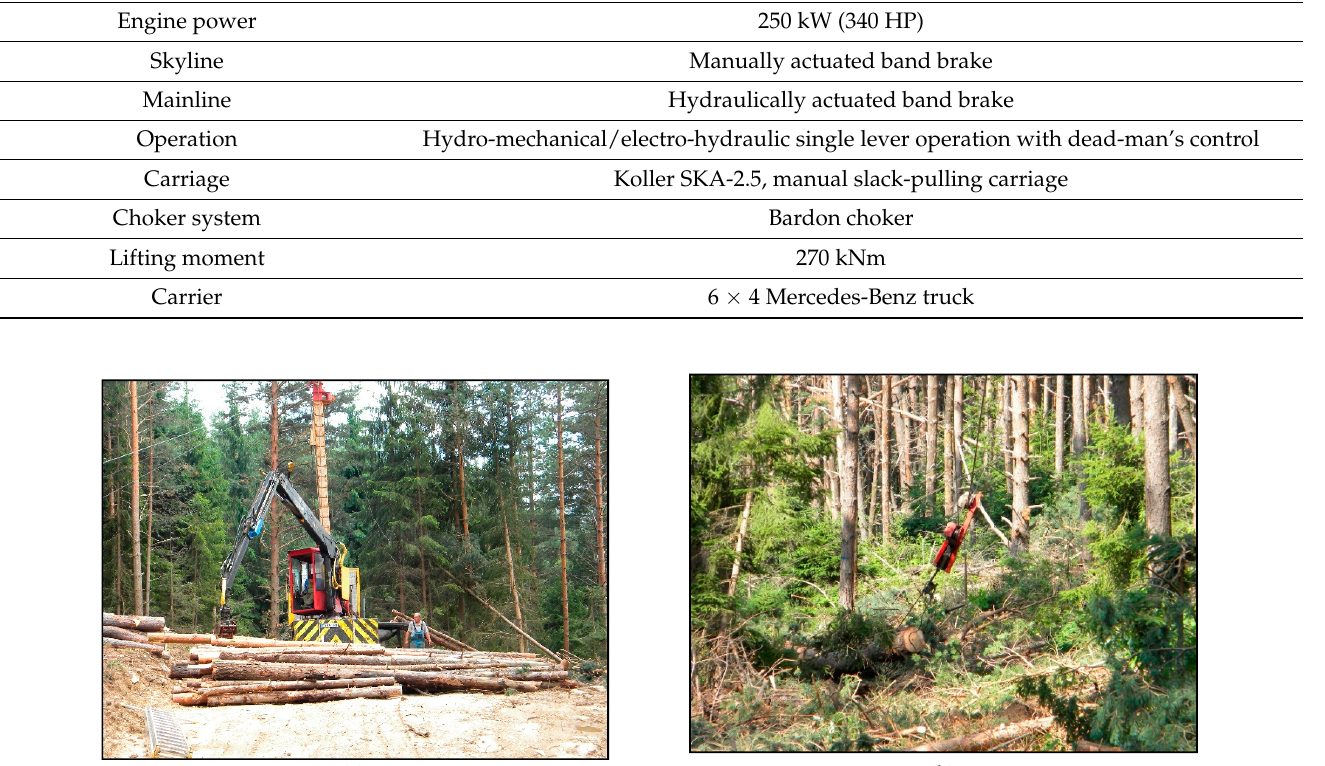
Table 2. Technical characteristics of the cable crane.